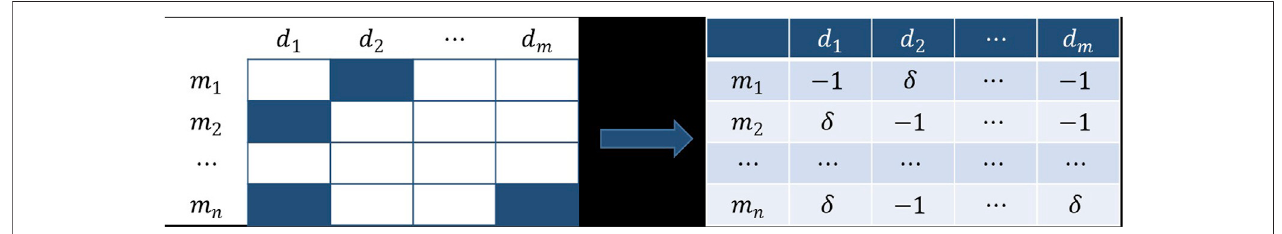
FIGURE 1 | Obtain the credibility matrix C according to the incidence matrix A .